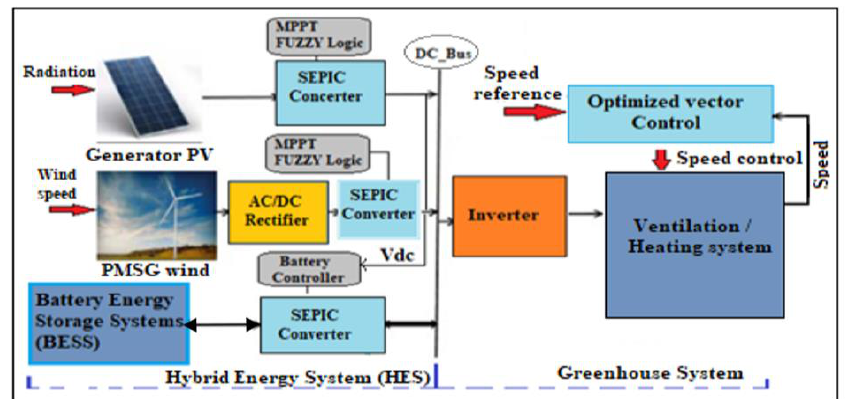
Figure 1. Conceptual scheme of the global system.